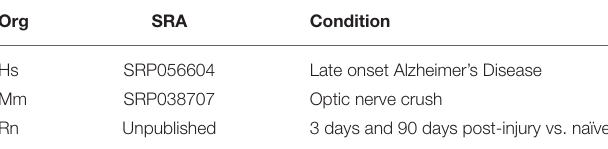
TABLE 5 | Datasets analyzed.